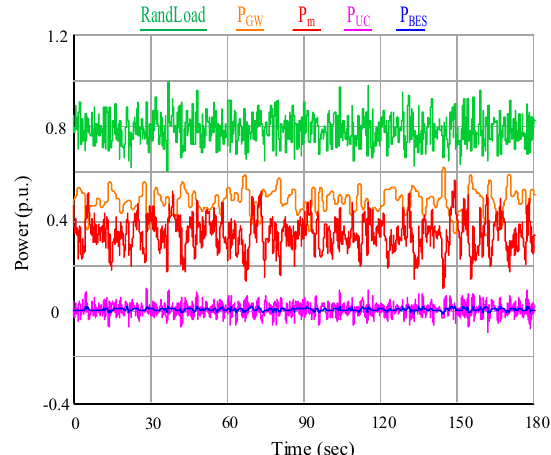
Fig. 11 Power flow of the system in scenario 4